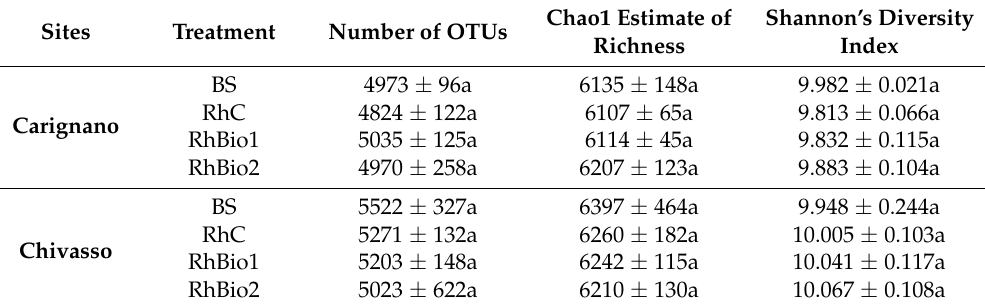
Table 1. The bacterial diversity indices (at 97% sequence similarity) in bulk soils (BS), and the rhizospheres of untreated control maize plants (RhC) and of plants treated with Bio1 (RhBio1) and Bio2 (RhBio2) in two sites.